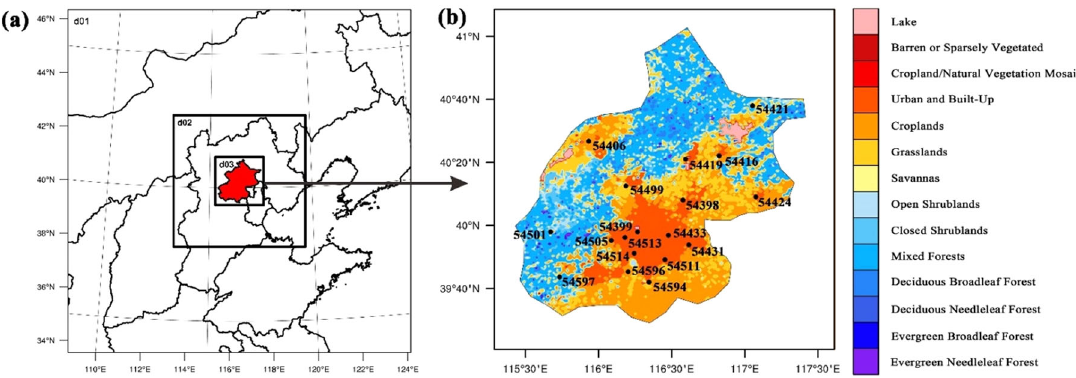
Fig. 1 Study area and land use distribution. a Study area and nested domains of the WRF simulation area; ( b ) land use distribution and location of meteorological stations.